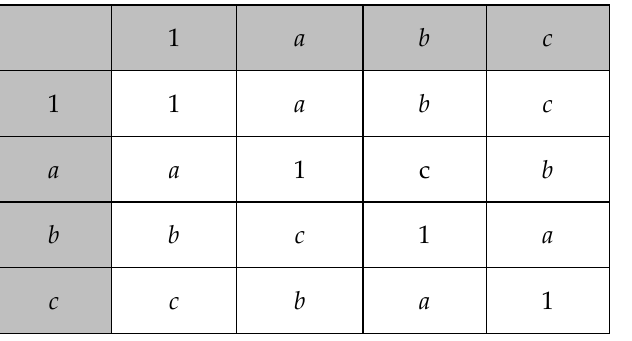
Table 12. The Cayley table of the